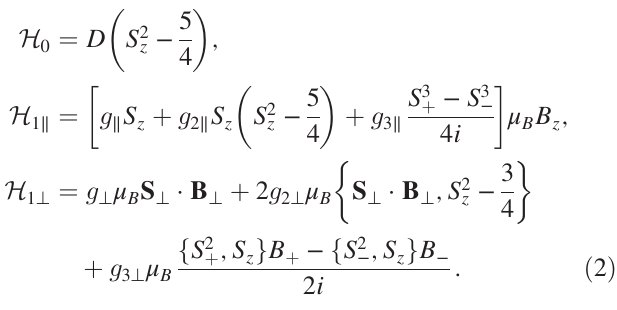
. The z . The vertical x